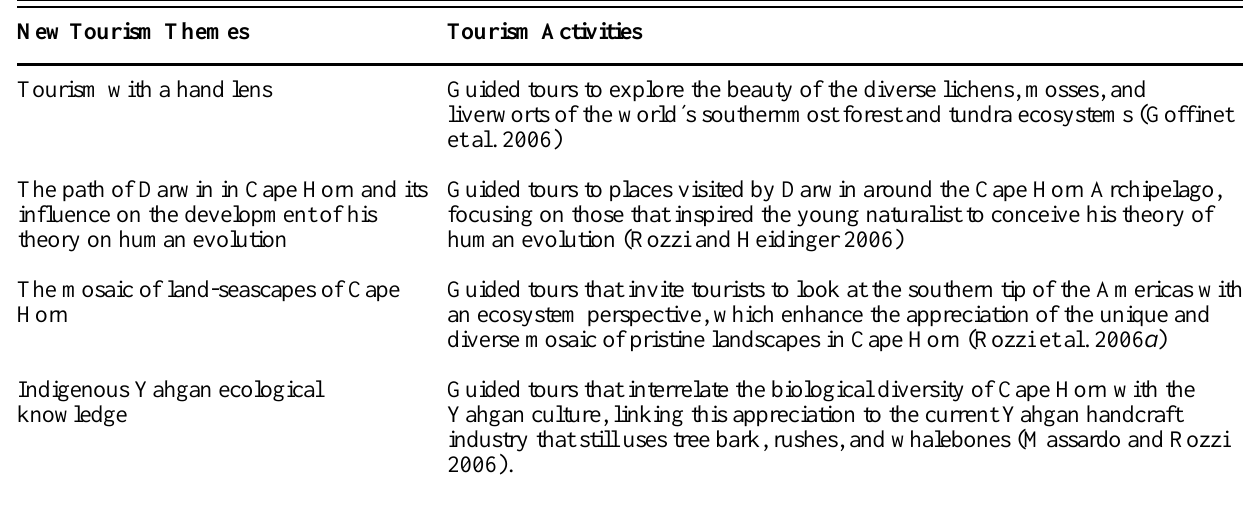
Table 3. Diversification of tourism thematic areas in Cape Horn. Omora scientists are developing these new topics through the preparation of guidebooks and training courses for tourist guides with the support of the regional